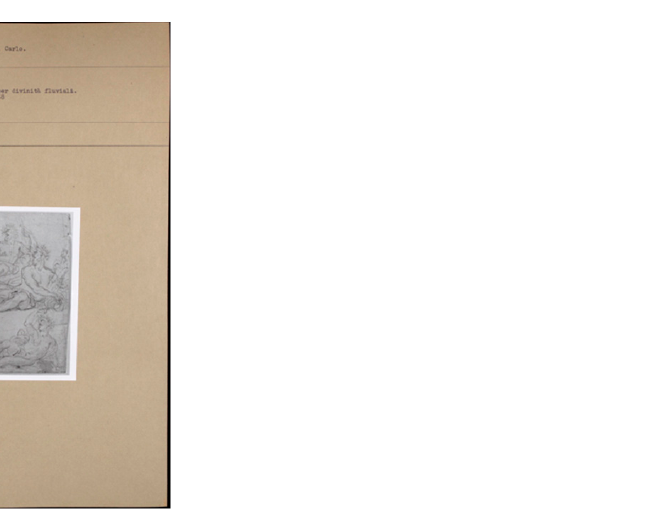
Figure 4. Exemple of Cardboard from Cini’s photographic archive ©EPFL Digital Humanities Laboratory.